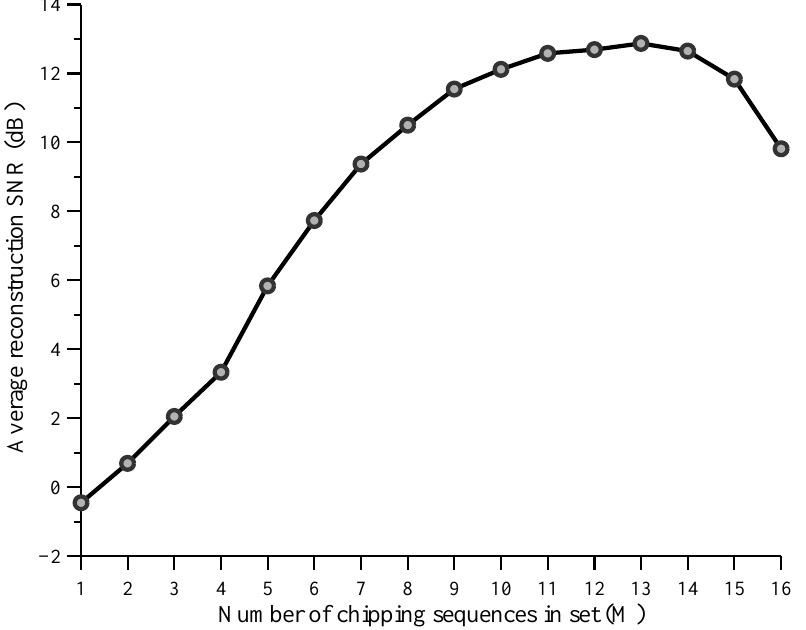
Figure 15. Average reconstruction signal to noise ratio for different numbers of